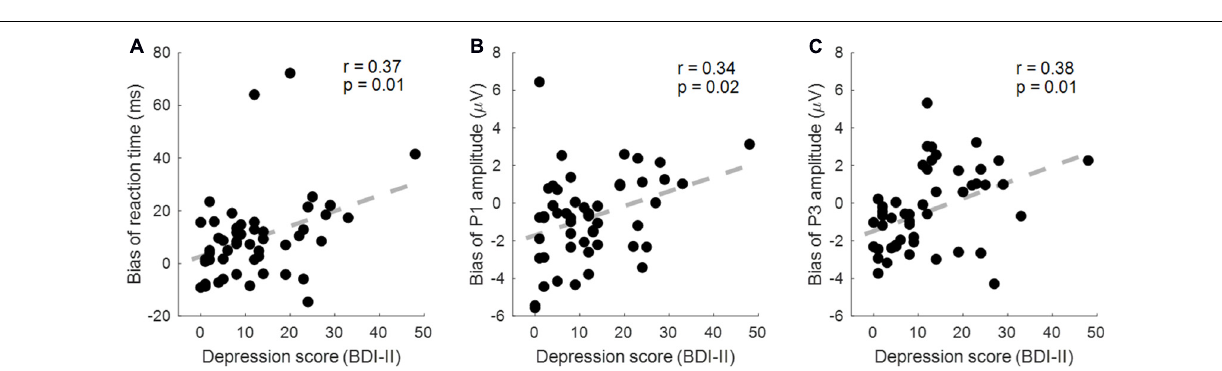
FIGURE 5 | The correlation between the depression score [Beck Depression Inventory Second Edition (BDI-II)] and behavioral/event-related potential (ERP) indexes. (A) The reaction time (RT) bias (invalid–valid) in the sad cue condition is correlated with the BDI score. (B) The P1 amplitude bias (valid–invalid) in the sad cue condition was correlated with the BDI score. (C) The P3 amplitude bias (valid–invalid) in the sad cue condition was correlated with the BDI